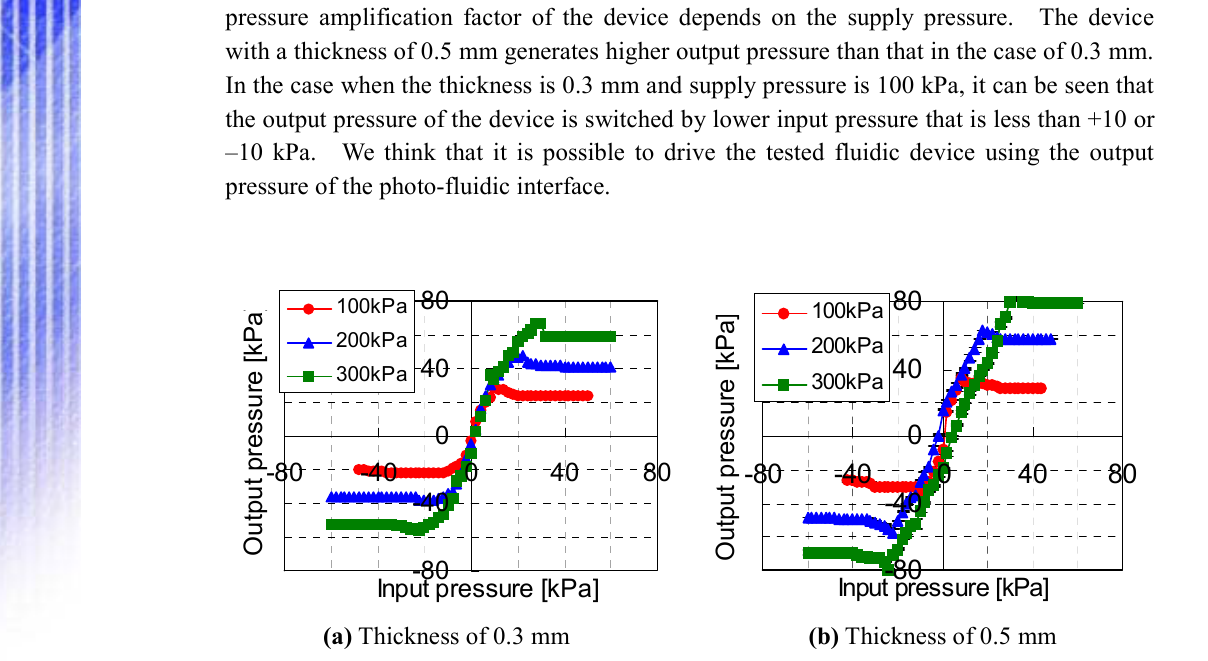
Fig. 4 Relation between input and output pressure of tested fluidic device